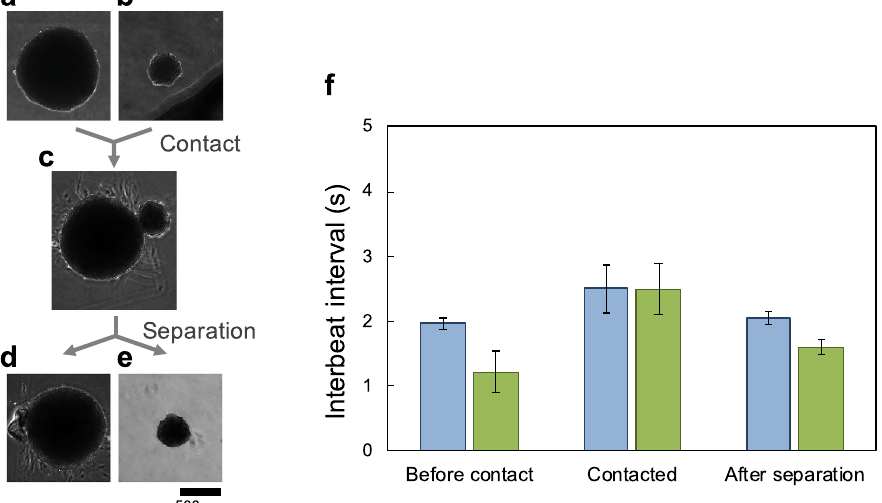
Figure 6. Distributions of interbeat intervals (IBIs) and fluctuations of the two hES cardiomyocyte clusters before and after their connection and after re-separation. ( a )–( e ): Micrographs of cardiomyocyte clusters. Micrographs of the large cluster ( a ) and small cluster ( b ) before contact. These clusters were measured when they had been cultivated for 7 days. The two hES cardiomyocyte clusters were connected ( c ). The measurement was performed 3 days after the two clusters contacted each other. Micrographs of the large cluster ( d ) and small cluster ( e ) after separation. The measurements were taken within 5 min of separation. ( f ): Distribution of IBIs and fluctuations of two clusters before contact, during contact, and after separation. Blue filled bar and error bar indicate the mean IBIs and SD of the large cluster. Green filled bar and error bar indicate the mean IBIs and SD of the small